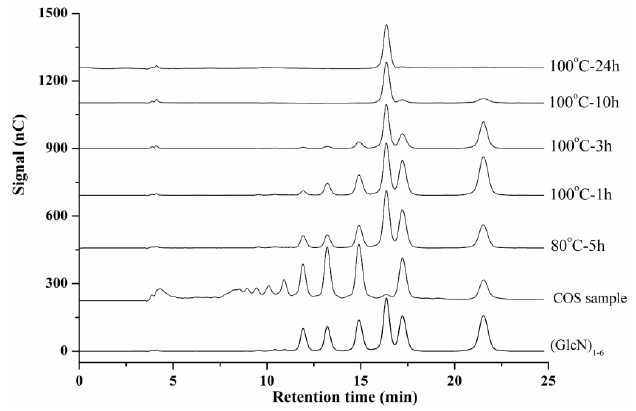
Figure 3. HPAEC-PAD chromatograms of (GlcN) 1–6 standards, COS technical concentrate, and the acid hydrolysis of COS technical concentrate under various conditions.